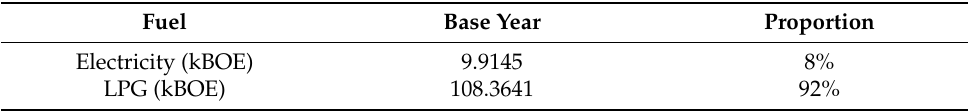
Figure 2. Sankey diagram of the residential sector of Cuenca, Ecuador, in the base year. (The figure shows the electricity losses given by the local distribution company. Losses due to marketing and distribution of LPG have not been included). Table 14. Energy consumption for DHW in the base